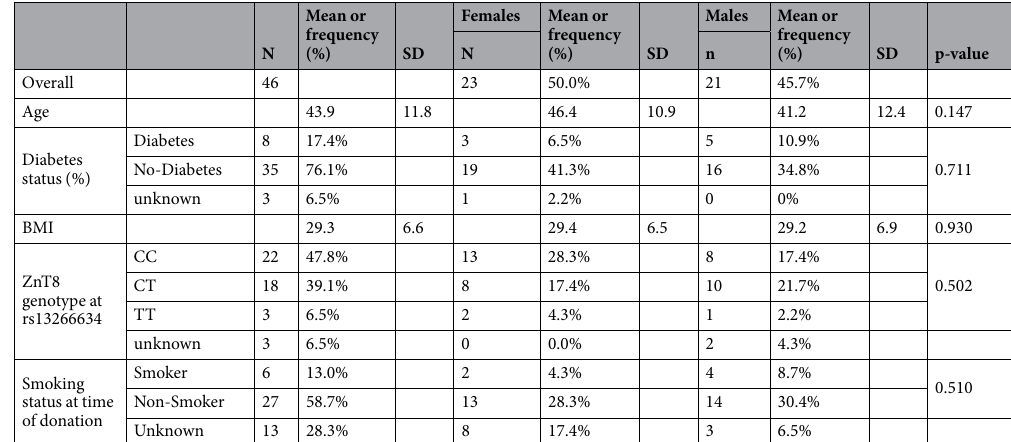
Overall Females Males n